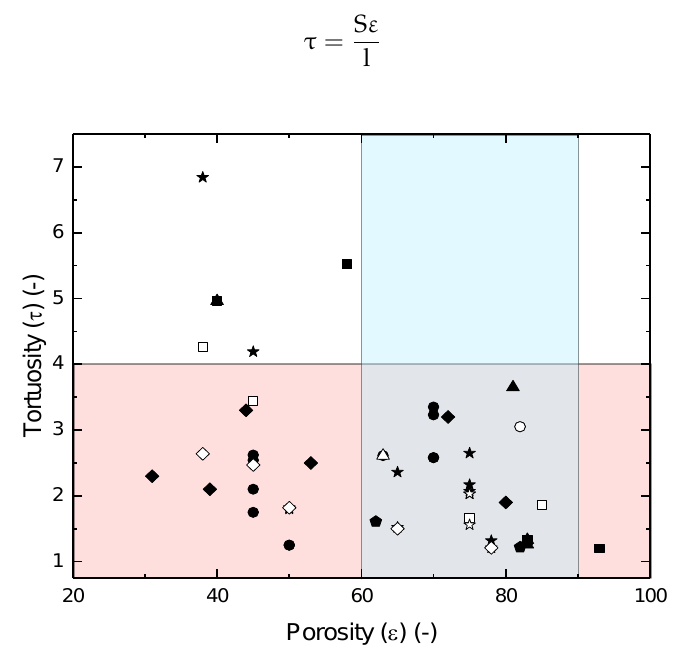
Figure 7. The porosity and tortuosity gathered from literature. (Filled black square ( ■ ) [191], Filled black circle ( ● ) [209], Filled black triangle ( ▲ ) [210], Filled lozenge ( ♦ ) [211], Filled black star ( ★ ) [212], Filled black pentagon ( ⬟ ) [213], Empty square (□) [214], Empty circle ( ○ ) [215] , Empty triangle [216] (∆), Empty lozenge (◊) [217], Empty star ( ☆ ) [218]).